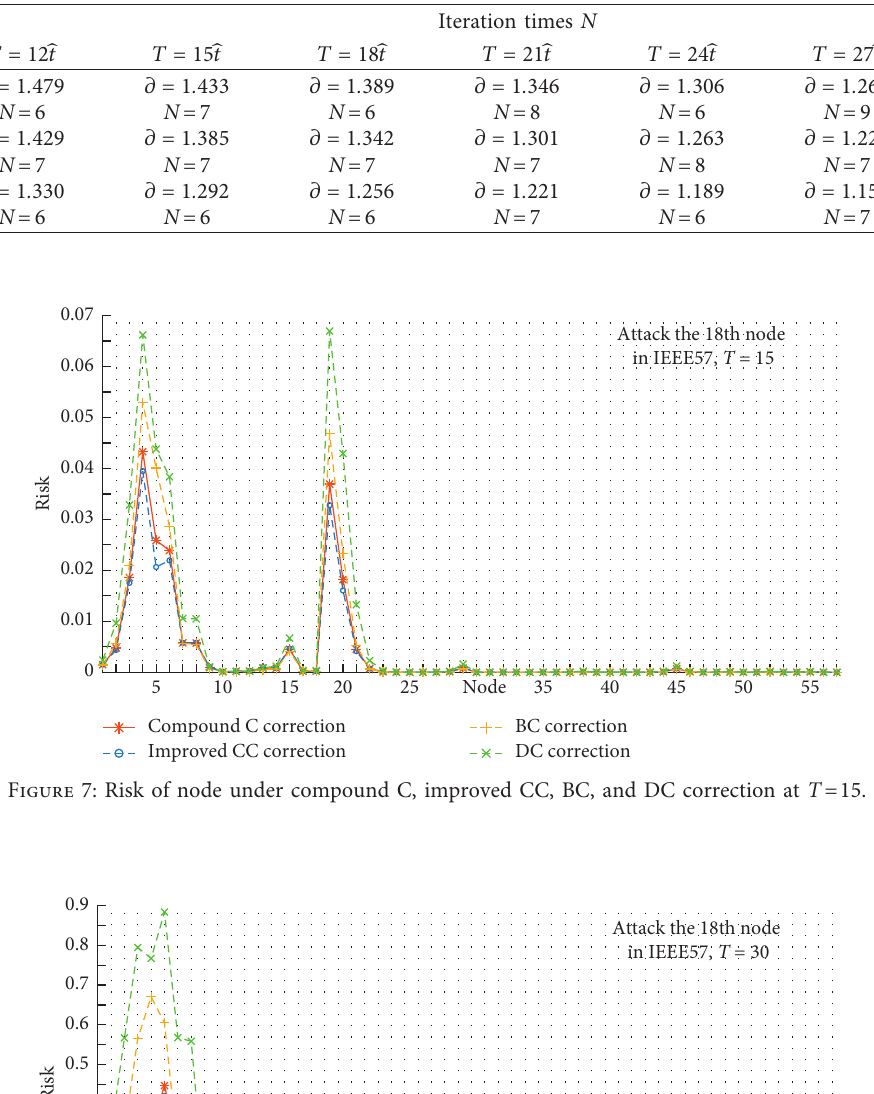
Table 2: Iteration results of the adaptive coefficients under the IEEE57 attacking the 18th node.